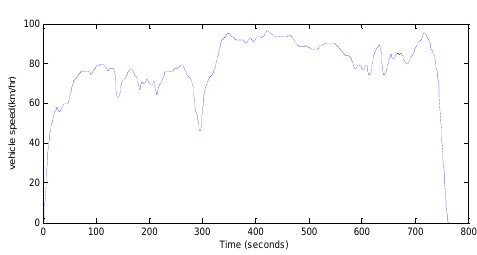
Figure 3. US EPA FTP75 highway driving cycle.